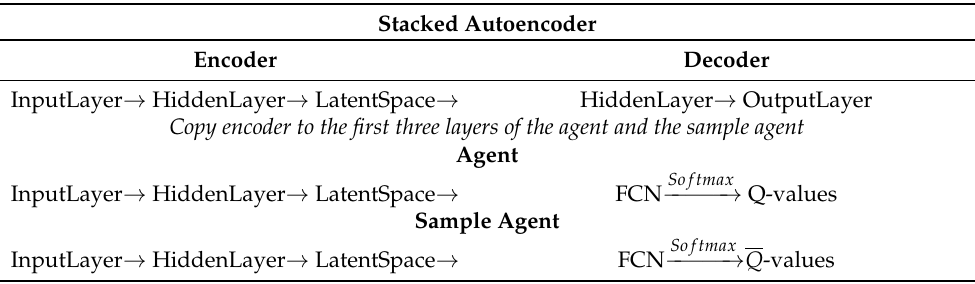
Table 7. Stacked Autoencoder (Encoder and Decoder), Agent and Sample Agent. The encoder is shared with agent and sample